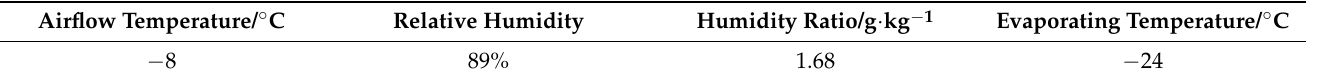
Table 2. The initial conditions of return air and evaporating temperature for simulation. Airflow Temperature/ ◦ C Relative Humidity Humidity Ratio/g · kg − 1 Evaporating Temperature/ ◦ C − 8 89% 1.68 − 24 The initial frost thickness and frost density is set as 2 × 10 − 5 m and 25 kg · m − 3 , respectively. The initial frost surface temperature is equal to the evaporating temperature.